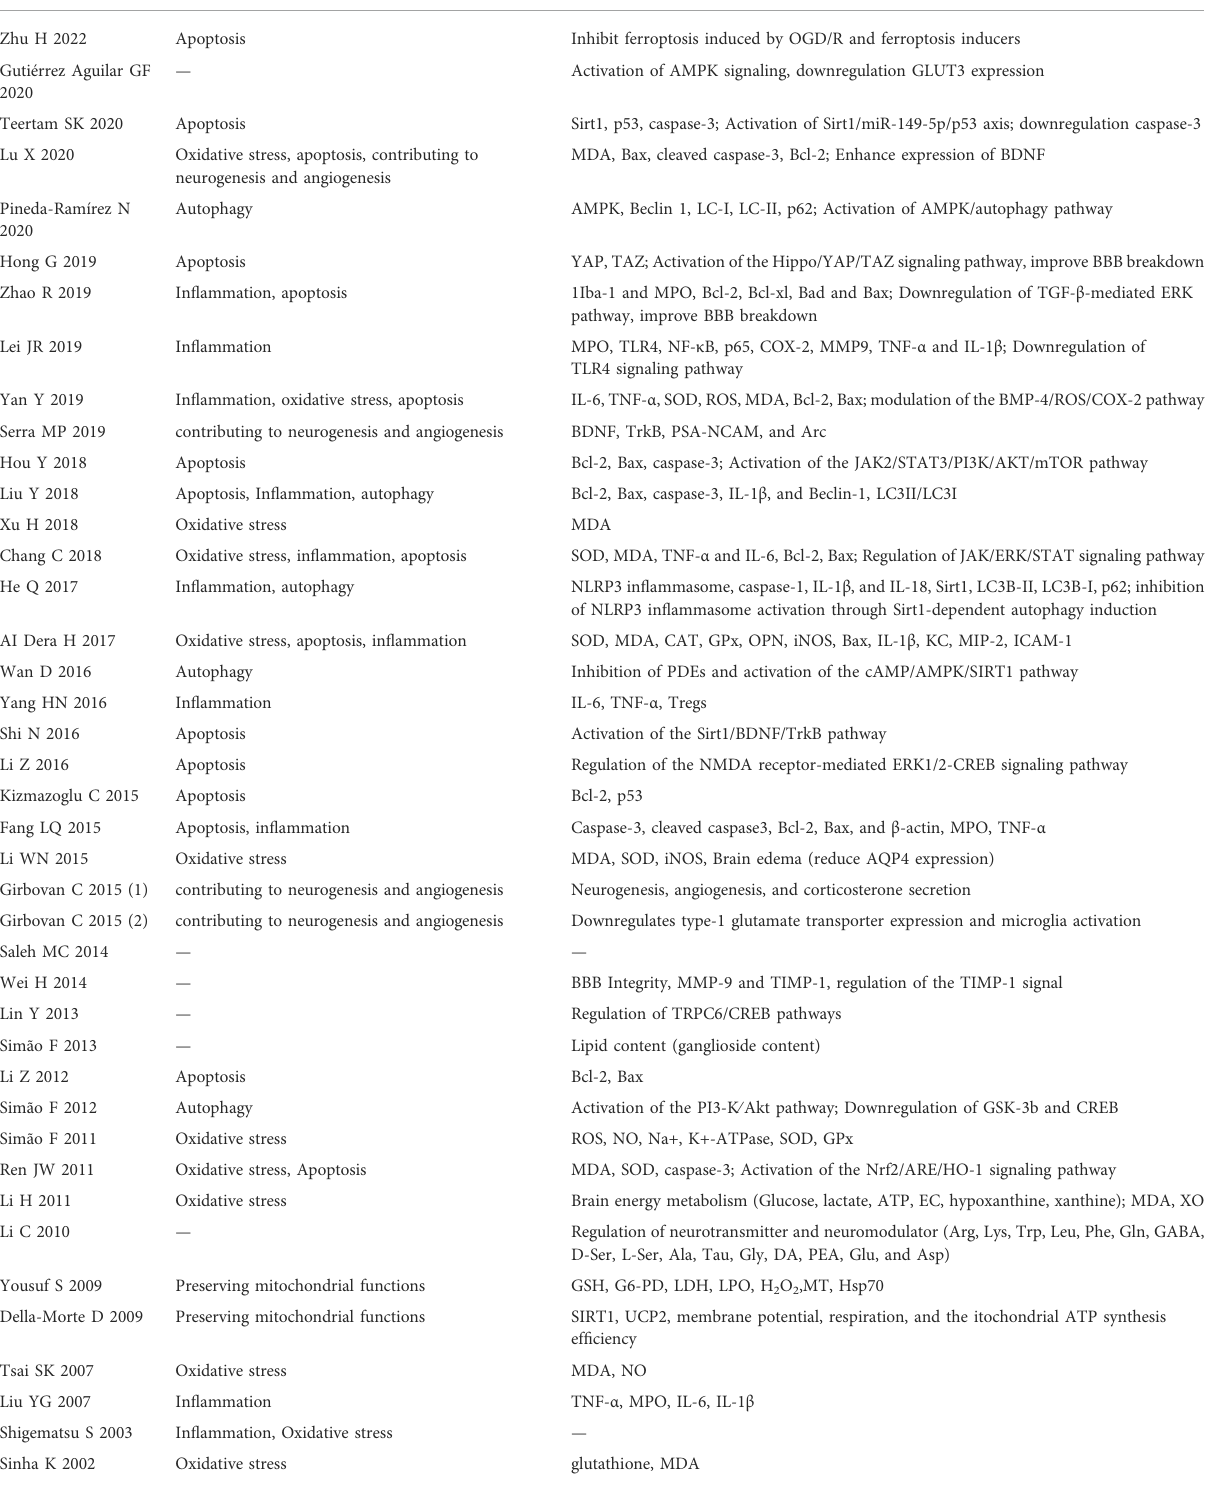
TABLE 6 The proposed molecular and cellular mechanism of the neuroprotective effect of